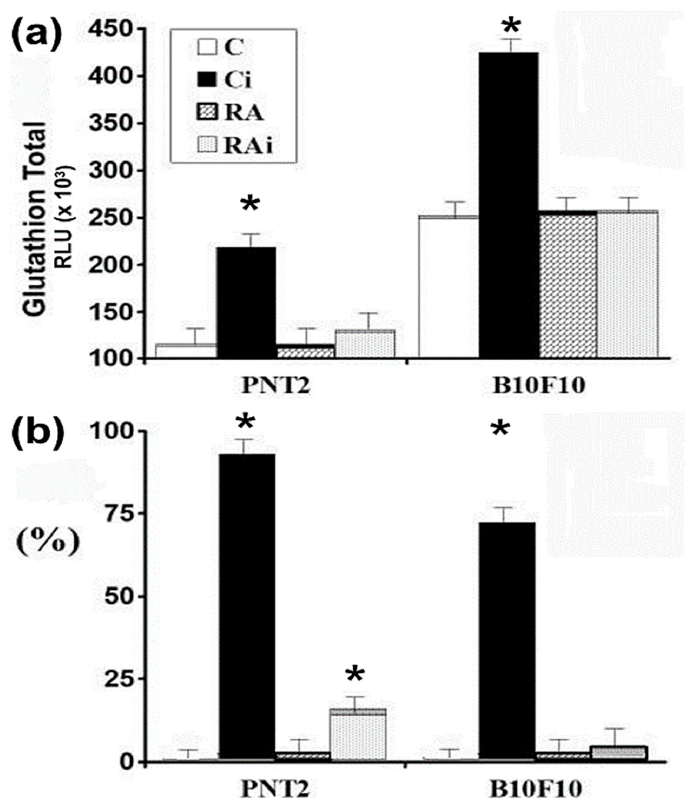
Figure 3. Total glutathione concentration in human prostate epithelial (PNT2) and B16F10